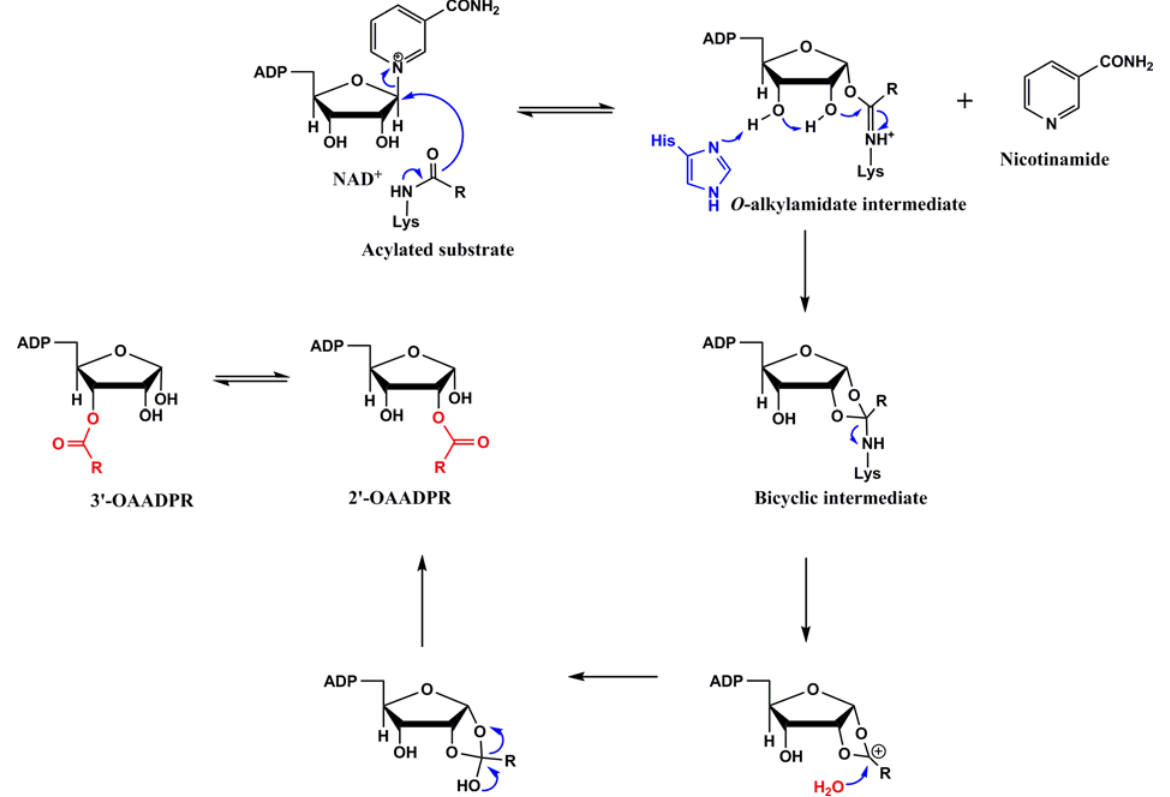
Fig 1. Schematic Representation of the Sirtuin Catalyzed Reaction Mechanism: The sirtuin catalyzed reaction proceeds via the nucleophilic attack of the carbonyl oxygen of the acylated substrate to the C1 ’ ribose of NAD + , resulting in the cleavage of the nicotinamide moiety of NAD + and formation of C1 0 - O -alkylimidate intermediate. The alkylimidate intermediate undergoes the cyclization reaction followed by hydrolysis, generating the deacylated product and 2 0 - O -acyl-ADP-ribose (OAADPr) species. The latter is slowly isomerized (non-enzymatically) to form 3 0 -OAADPr.